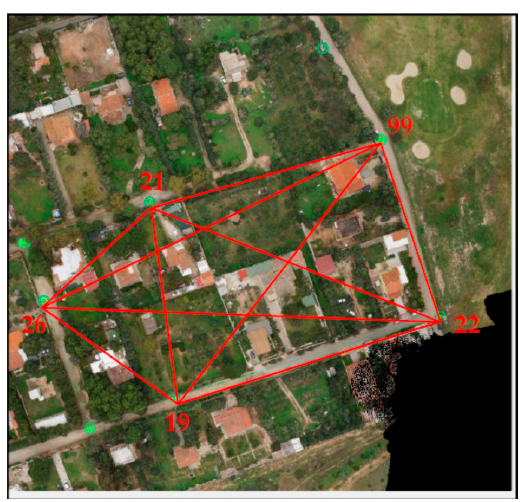
Figure 12. Distance measurements.